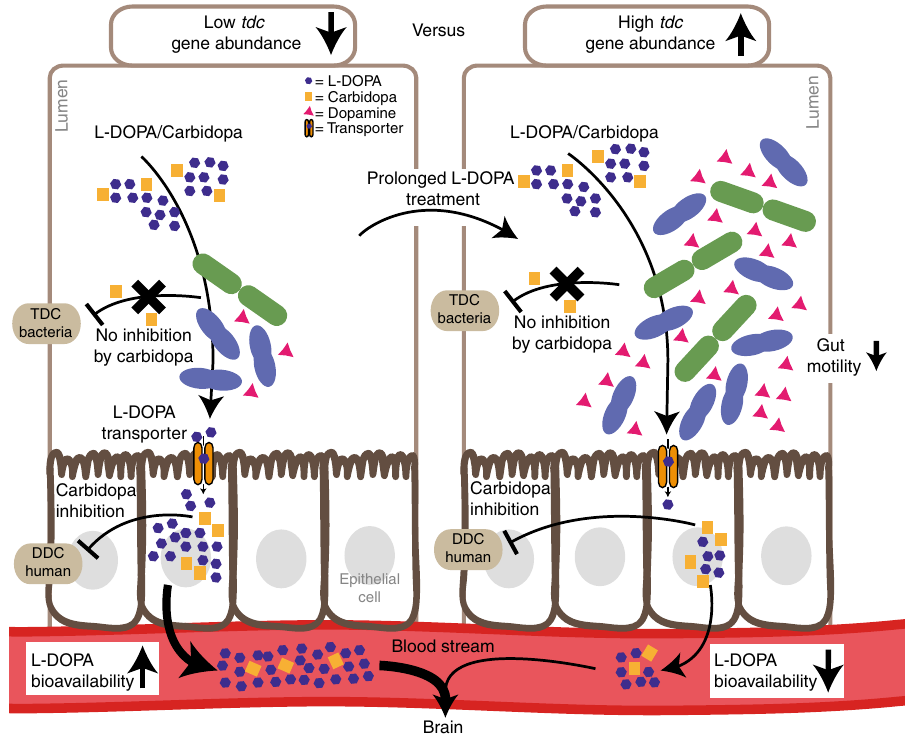
representing two opposing situations, in which the proximal small intestine is colonized by low (left) or high abundance of tyrosine decarboxylase-encoding bacteria. The latter could result from or lead to increased individual L-DOPA dosage